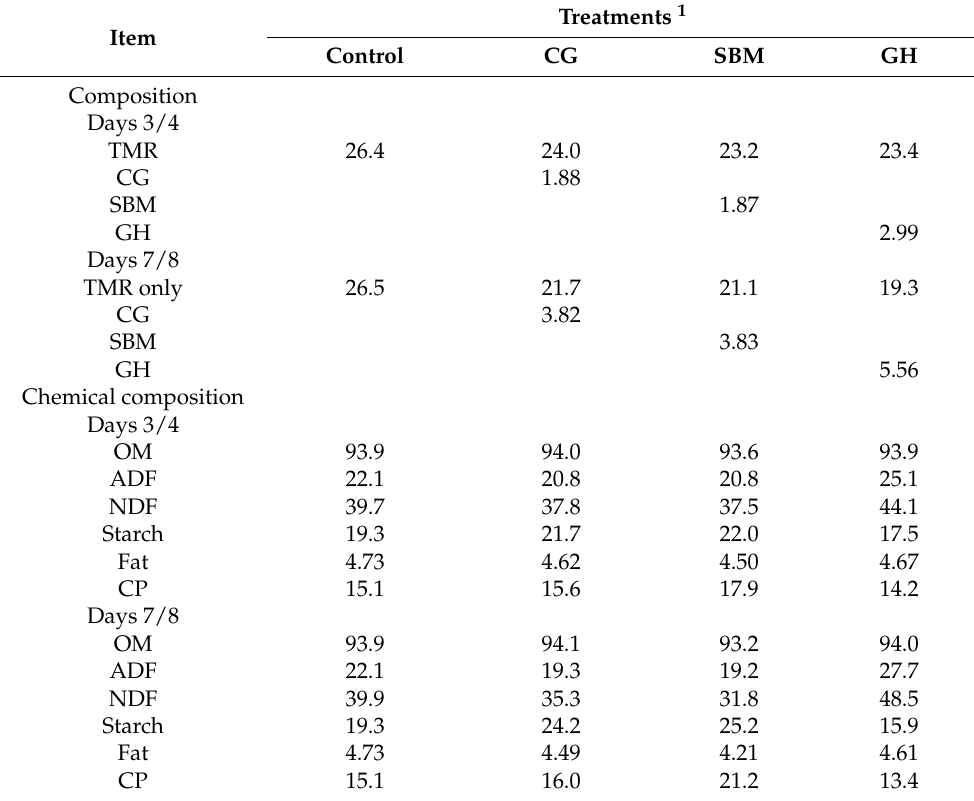
Table 4. Ingredient (kg/d, DM basis) and chemical composition of the experimental diets (% of dry matter unless otherwise